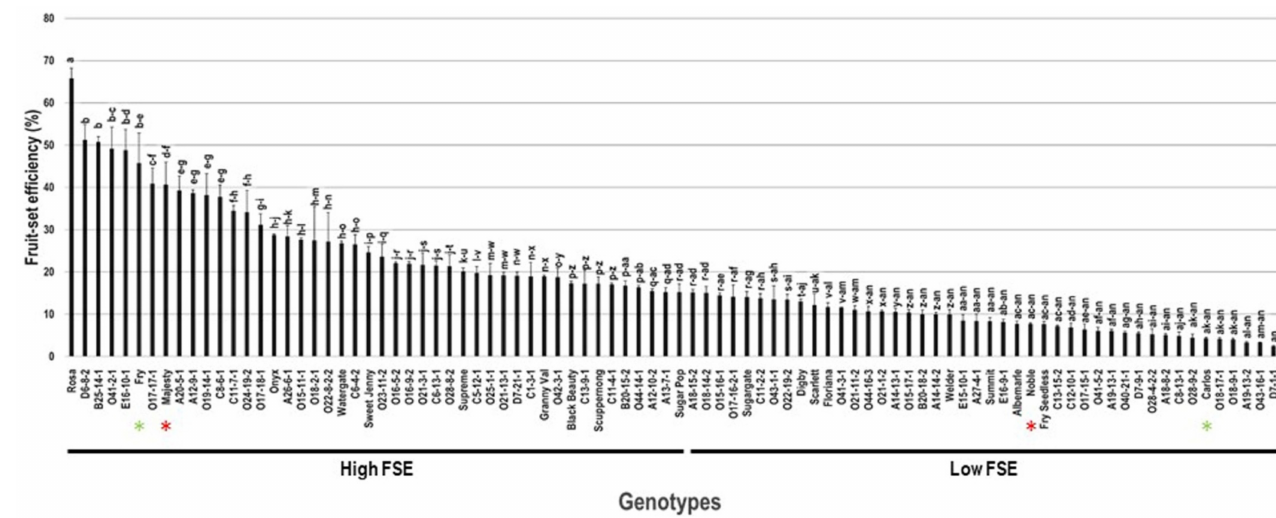
Figure 5. Characterization of the number of fruit-set efficiency (FSE) trait among muscadine population ( n = 90). The bars represent the mean FSE ( ± SD) results from three biological replicates (three vines) over three years ( n = 9). The y-axis refers to the fruit-set efficiency. Means within columns for the same letter followed by different letters differ significantly by Tukey’s test ( p < 0.05). Based on median FSE (~15.2%), the population was divided into two groups of high (43 genotypes, or 47.8%) and low (47 genotypes, 52.2%) FSE. Other details are as in Figure 1.